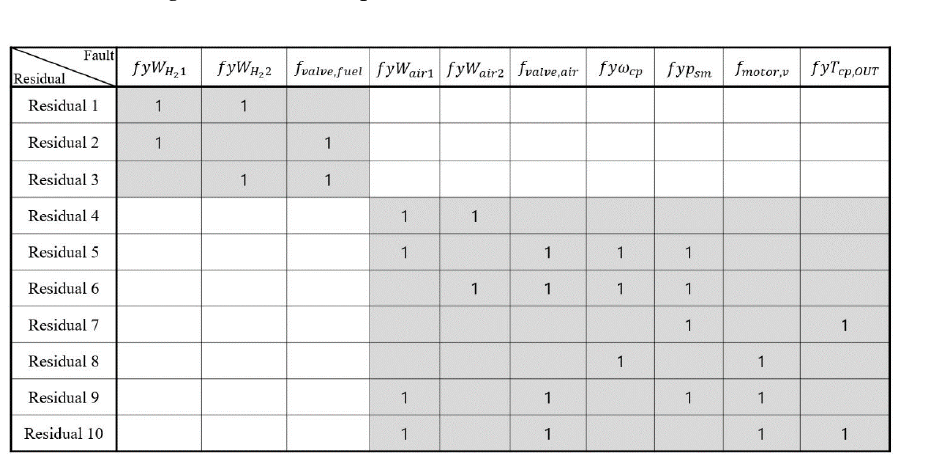
Figure 7. Fault signature matrix.